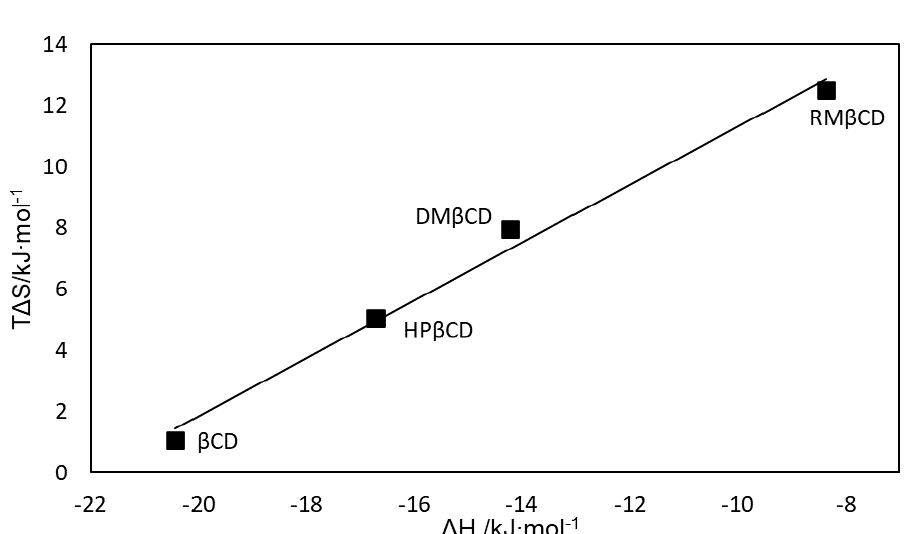
Figure 4. The enthalpy-entropy compensation plot for inclusion complexes of sertraline hydrochlo- ride molecules with chosen β -cyclodextrin molecules: β CD [41], DM β CD [41], HP β CD [42], RM β CD (this work). The determined coefficients of the linear equation T ∆ S = α · ∆ H + T ∆ S 0 [21] with R 2 = 0.99 are: α = (0.946 ± 0.068) kJ · mol − 1 and T ∆ S 0 = (20.8 ± 1.1) kJ · mol − 1 .